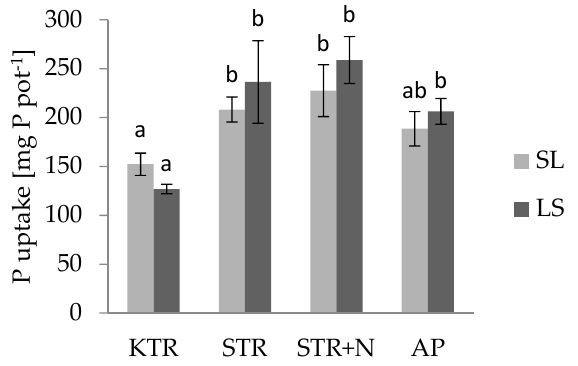
Figure 3. Uptake of P by grass (sum for four harvests). The standard deviation within each treatment (n = 3) is indicated by the line extending from the column. Different letters (a, b) indicate significant differences ( p < 0.05).